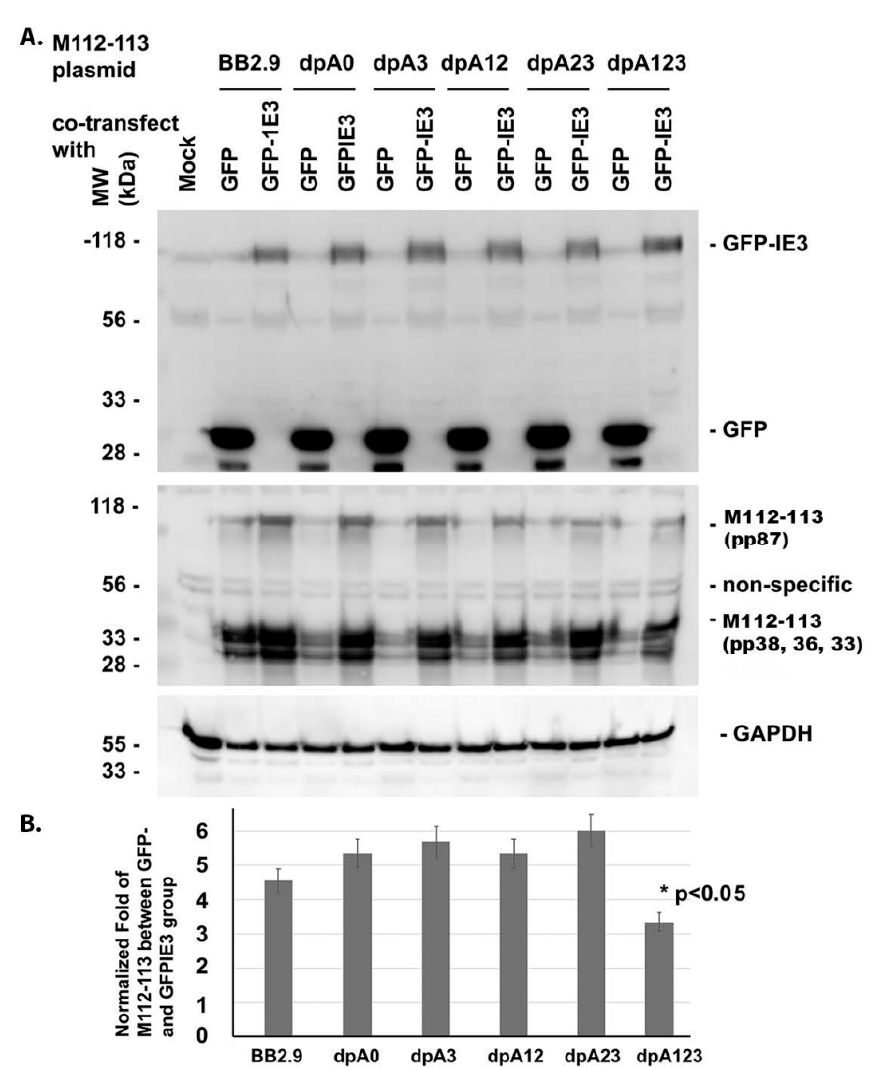
Figure 2. Western blot assay to determine the activation of M112-113 by immediate-early 3 (IE3). ( A ) The M112-113 plasmids were cotransfected with either GFP- or GFPIE3-expressing plasmid into NIH3T3 cells for 24 h. The whole-cell lysates were collected for a Western blot assay using antibodies against GFP, M112-113, or GAPDH to examine the protein as marked on the right side. One representative blot of three experiments is shown. ( B ) We have performed three independent experiments; the densitometry was obtained by averaging the three Western blots. The densities of the protein bands of M112-113 were first normalized with GAPDH and then compared between the GFPIE3 group and the GFP group. The ratios from 3 independent experiments are shown as a bar graph at the bottom. A Student’s t -test was applied to statistically analyze the data, and the significance was only seen for the group of dpA123 when compared to the other groups: * p < 0.05.